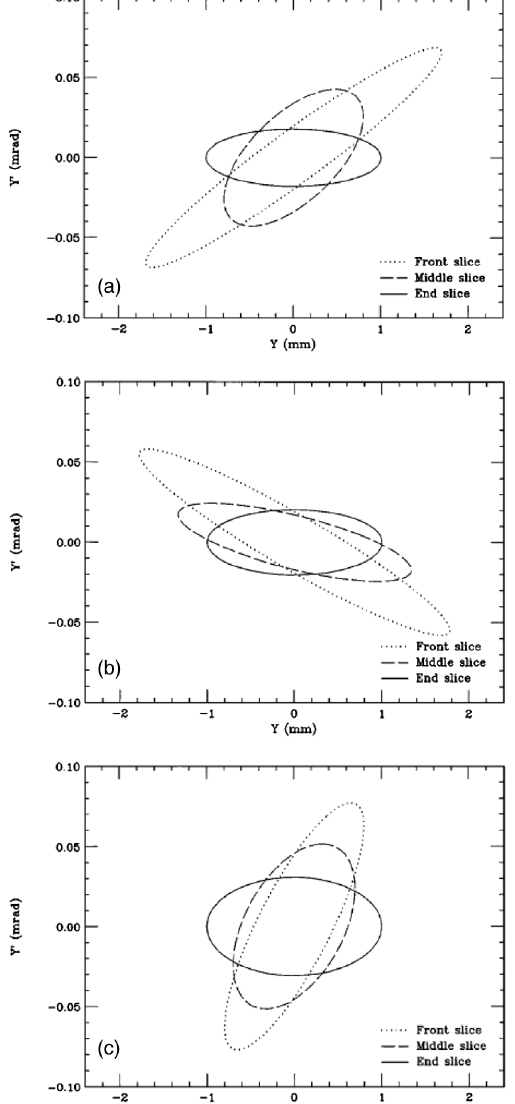
FIG. 10. Experimental BNL measurements (from [20]) show- ing the slice phase-space ellipses of the front, middle, and end slices, for solenoid currents of 102 A (a), 106 A (b), and 110 A (c). As predicted, the slices rotate relative to each other as the solenoid focal length is changed. The projected emittance is minimized at a solenoid current of 106 A.